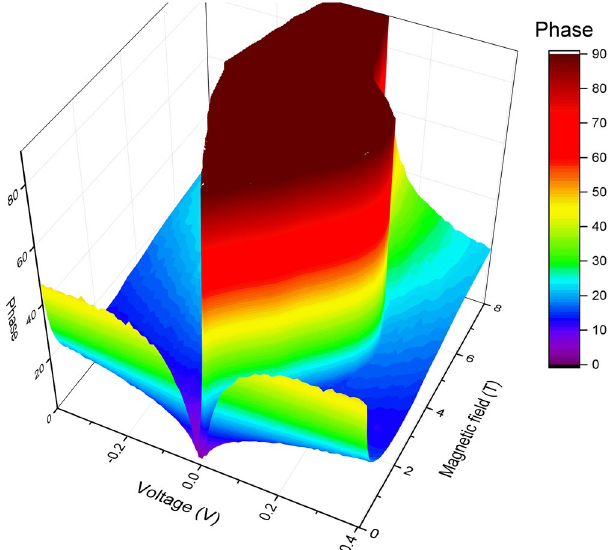
Figure 5. The 3D plot of bias voltage and magnetic field dependence of the phase of the sample U at 100 kHz at T = 35 mK. There is a threshold voltage where phase jumps from 90 degrees to 10–15 degrees. A similar threshold behavior is observed in the dc current–voltage dependences.